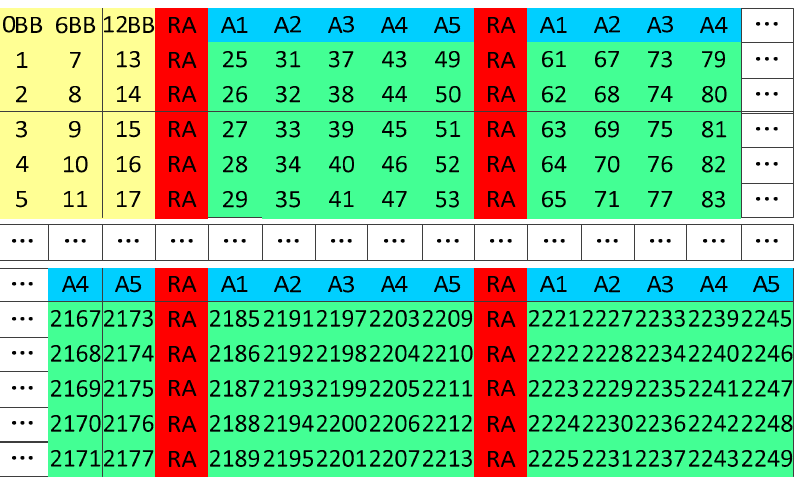
Figure 3. VDE-Terrestrial (VDE-TER) ship-to-shore slot to Logical Channel (LC) mapping.